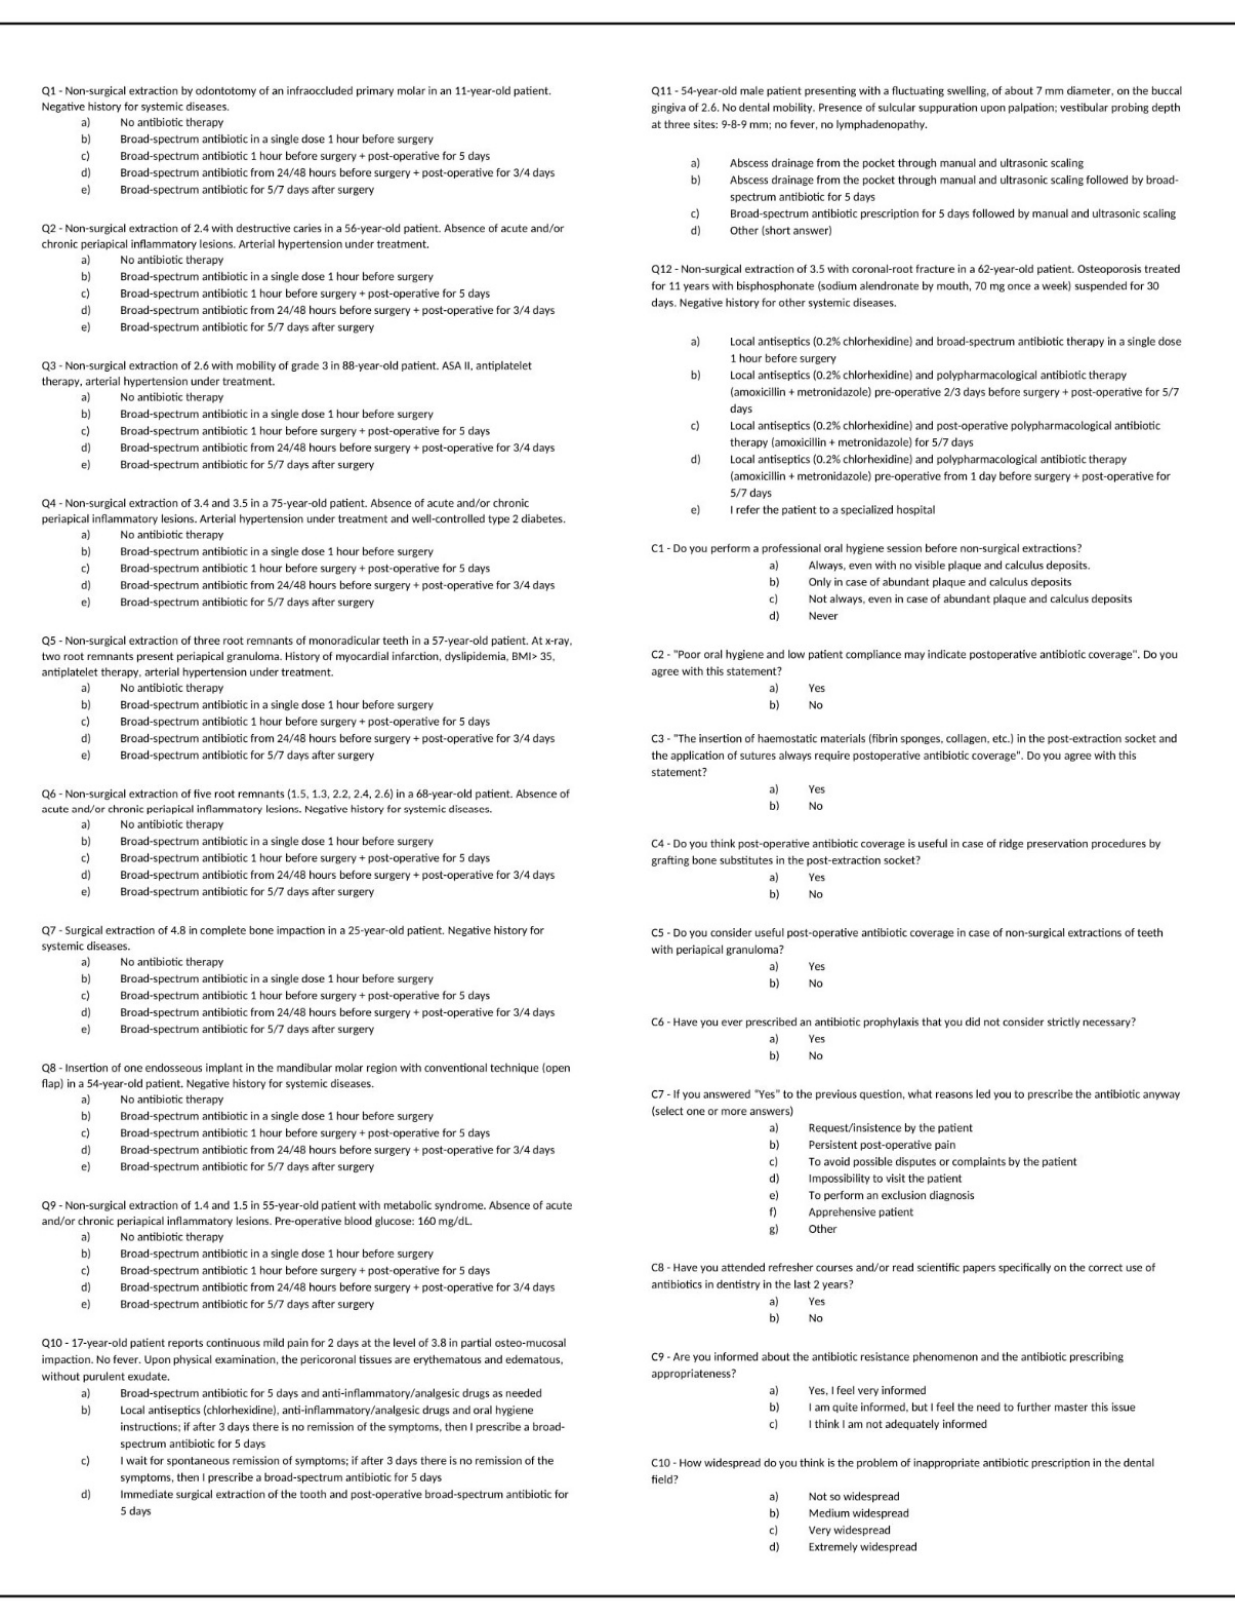
Figure 2. Questionnaire including clinical cases (Q1–Q12) and short-form considerations (C1–C10) about the use of antibiotics in specific dental procedures.